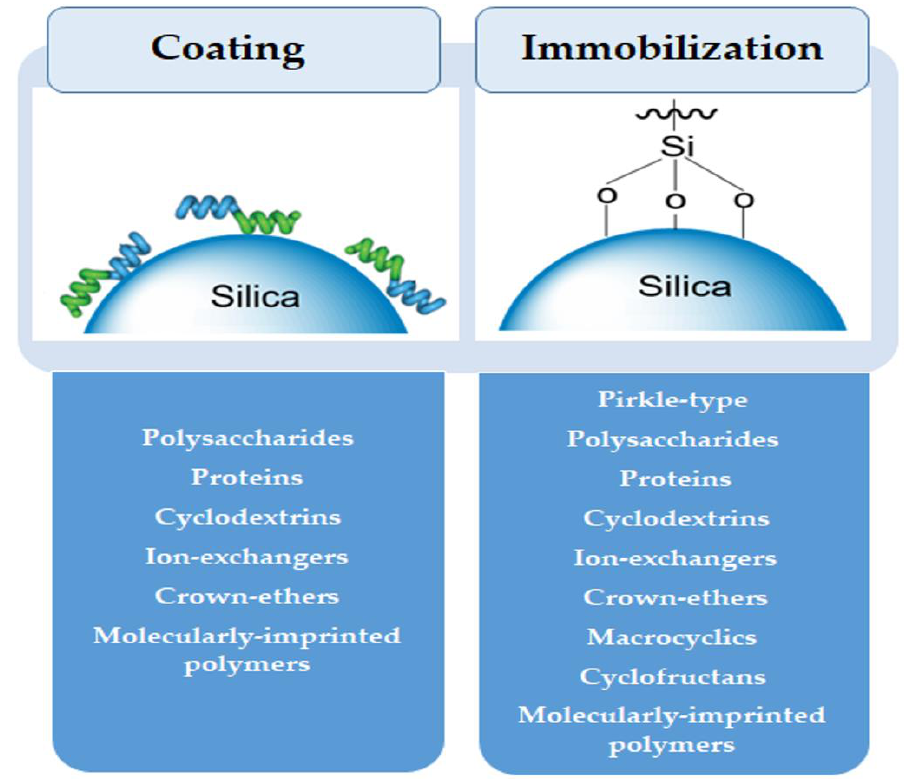
Figure 1. Types of chiral selectors typically coated or immobilized onto the chromatographic